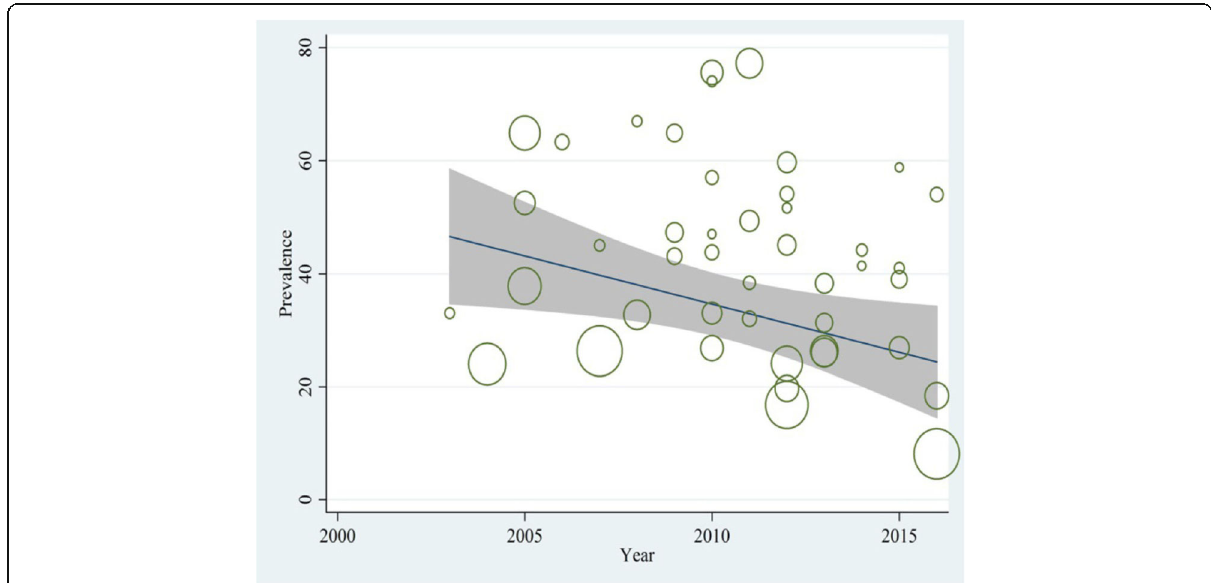
Fig. 3 Reduction in prevalence of NSIs during 2003 – 2016 according to meta-regression. This figure shows meta-regression analysis of needlestick prevalence based on selected studies ’ publication years. The vertical axis represents the prevalence, and the horizontal axis represents the selected studies ’ publication year. Slope of the regression line indicates an increase or decrease of study effect using REML estimation. Given the slope of the regression line is descending in this figure, it can be inferred that as the studies ’ publication year has been increased, the prevalence of needlestick has been decreased. Gray color lines around the slope of the regression line indicate 95% confidence interval. Each circle demonstrates one selected study and the size of each circle corresponds to the weight assigned to each study. Reverse weight corresponds to the standard error of each